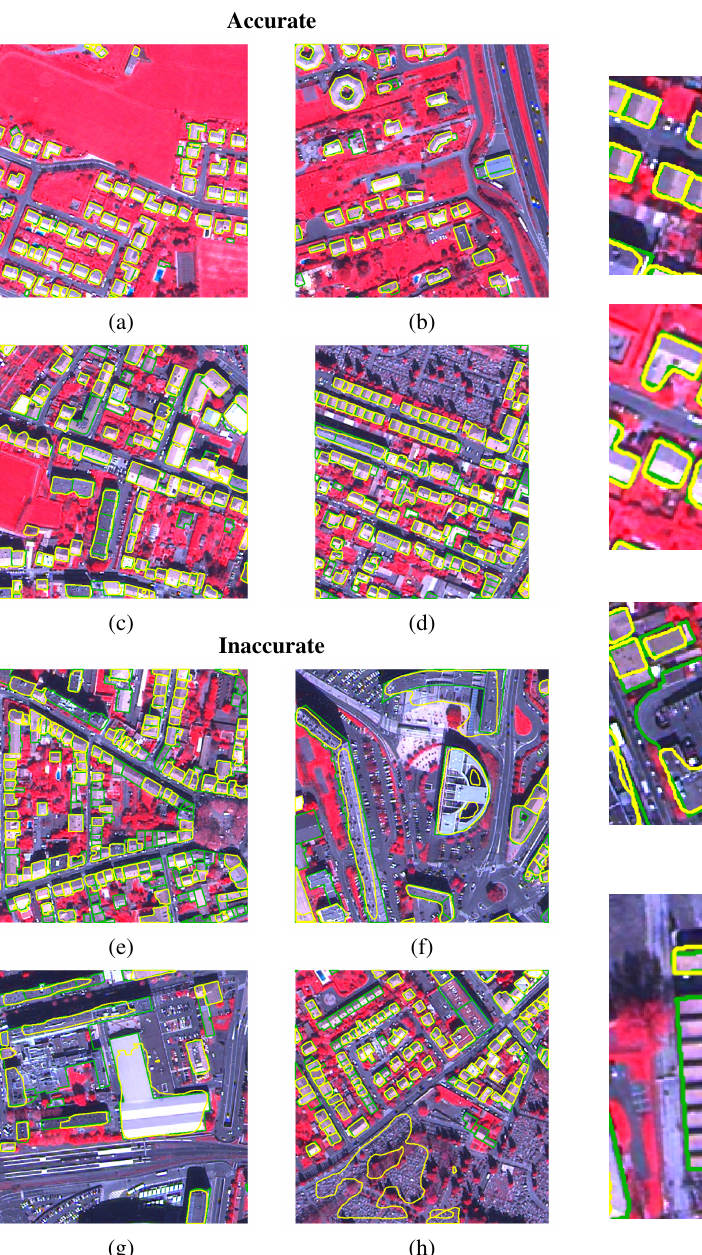
Figure 11. Some details of predictions. In yellow are shown Figure 10. Some example predictions for the tiled test images predictions, while in green the reference samples. Note that only for the baseline model. In yellow are shown predictions, while in predictions with IoU ≥ 0.5 are green the reference samples. Note that only predictions with IoU ≥ 0.5 are shown.